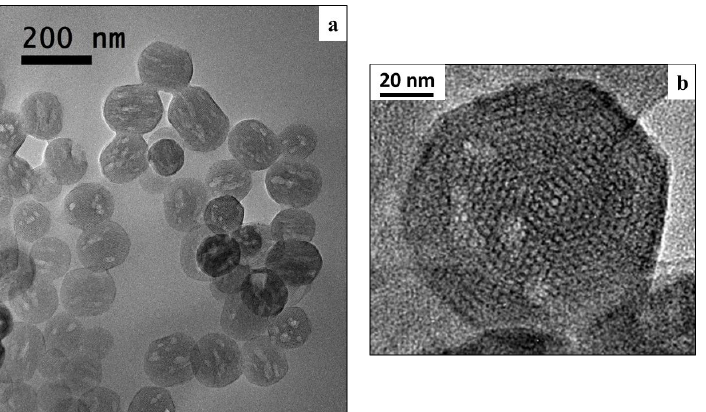
Figure 2. HR-TEM images of Ca_MCM-41 particles at different magnifications to evaluate the particle shape, dimension and the ordered structure of the obtained material: ( a ) overview of Ca_MCM-41 particles; ( b ) detailed view of a single particle.